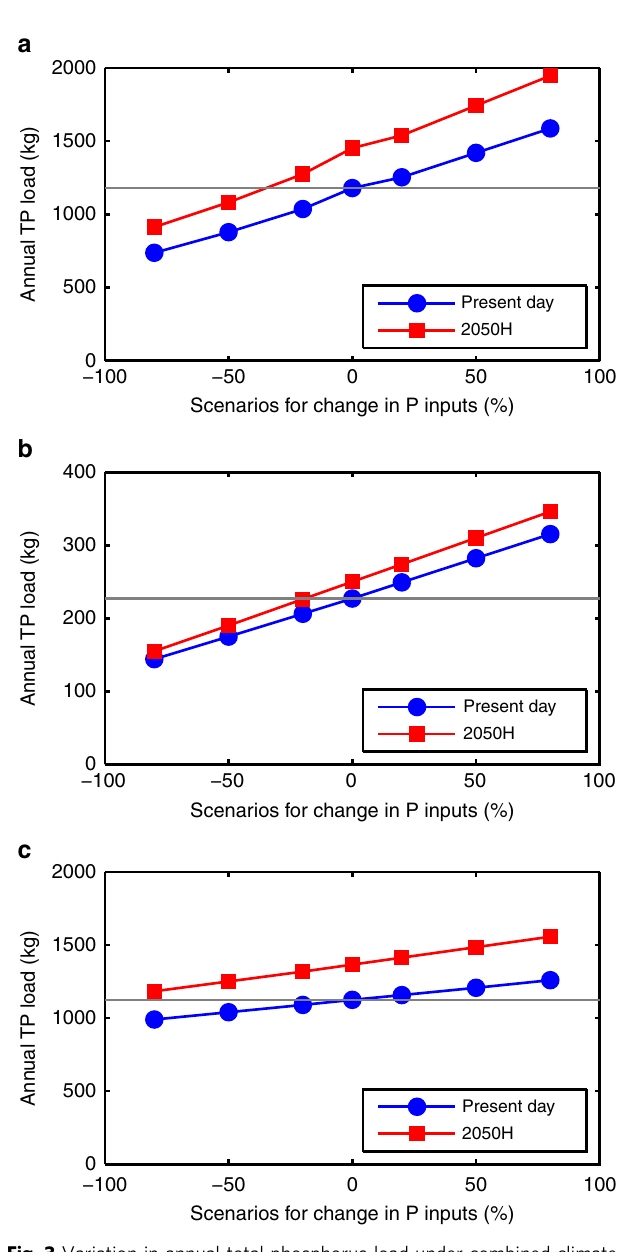
Fig. 3 Variation in annual total phosphorus load under combined climate change and agricultural change scenarios for three UK